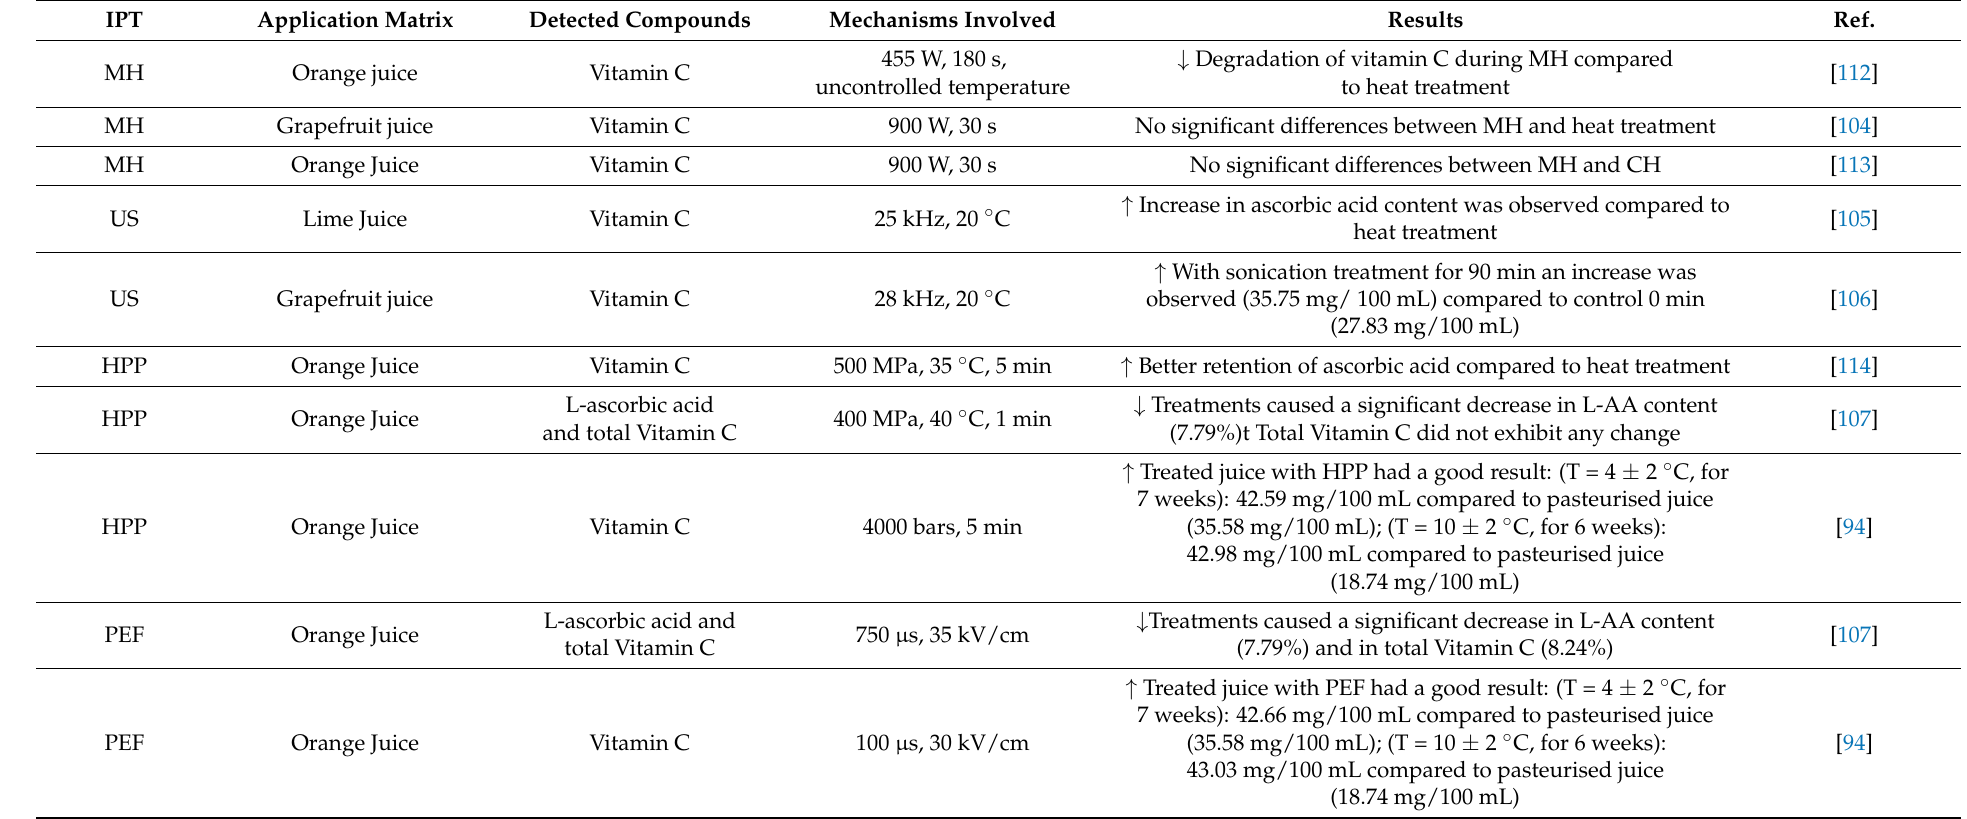
Table 4. Effects of innovative processing technologies on citrus vitamin C